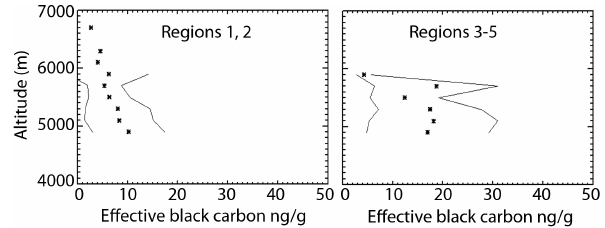
Figure 9. LAHM determined eBC values averaged by altitude bins plotted with ± 1 standard deviation (lines) by altitude for the north- ern (regions 1 and 2) mountains and the southern (regions 3–5) mountains in the Cordillera Blanca. Absorbing particles in snow in regions 1 and 2 are likely primarily dust while regions 3–5 are strongly influenced by pollution from the city of Huaraz.